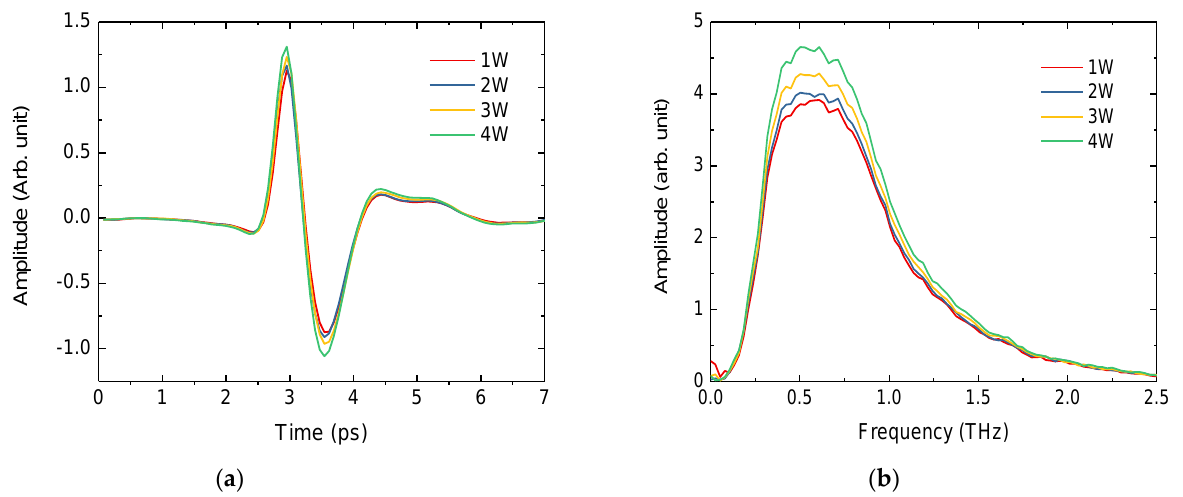
Figure 3. Reflected terahertz waveform of water-dispersed emeraldine salt polyaniline (ES-PANI) nanoparticles based on the applied laser power. ( a ) Time- and ( b ) frequency-domain waveforms. The legend indicates the power of the continuous-wave near-infrared (CW-NIR) laser with a wavelength of 808 nm. The terahertz waveform without CW-NIR irradiation is identical to the waveform of 1 W.